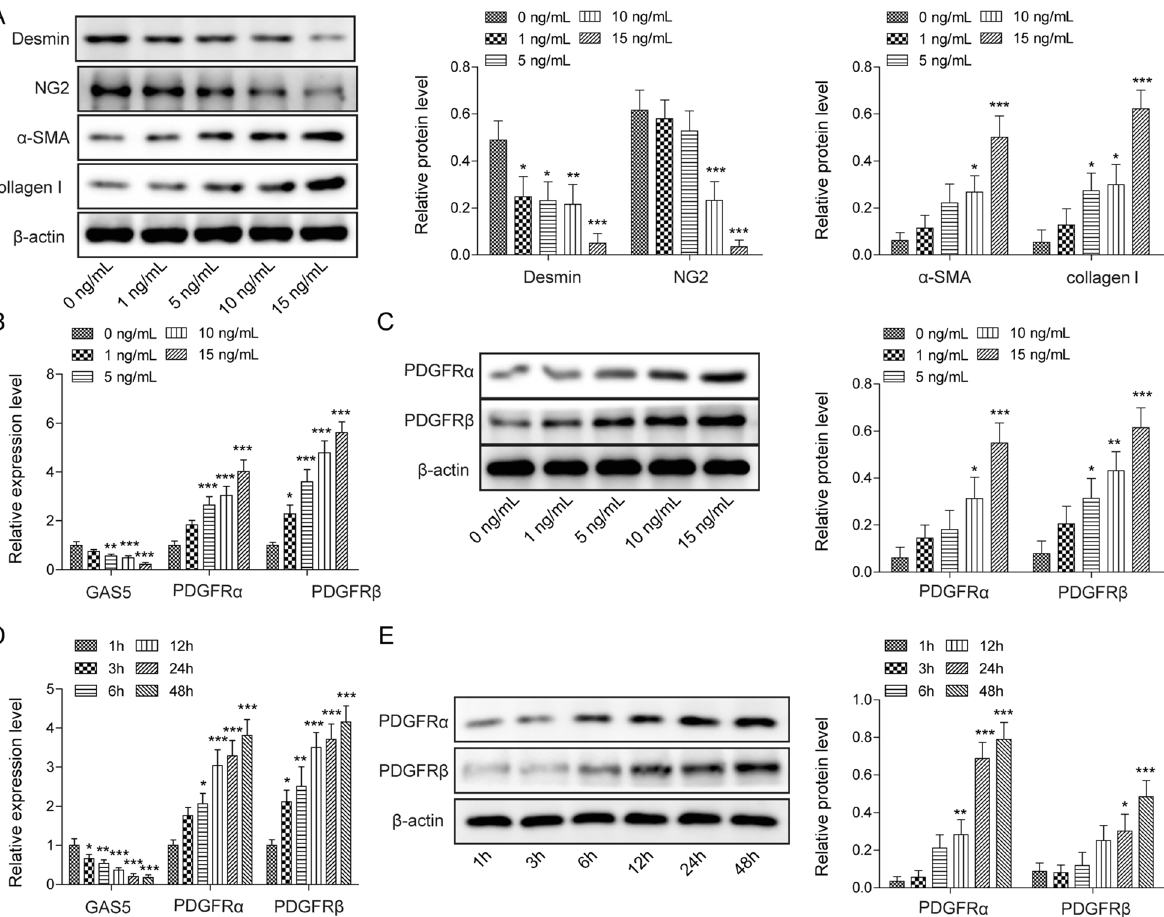
Fig. 2 TGF-β1 induced pericyte–myofibroblast transformation in a dose- or time-dependent manner. Pericytes were exposed to different TGF-β1 concentrations (0, 1, 5, 10, and 15 ng/mL) for 12 h. A Western blotting analysis of the levels of pericyte markers (desmin, NG-2) and myofibroblast markers (α-SMA, collagen I). B RT-qPCR analysis of the expressions of GAS5 and PDGFR α/β in pericytes. C The expression of PDGFR α/β was evaluated via Western blotting. Pericytes were treated with 10 ng/mL of TGF-β1 at different time periods (1, 3, 6, 12, 24, and 48 h). D The expressions of GAS5 and PDGFR α/β were examined via RT-qPCR. E Western blotting analysis of the expression of PDGFR α/β. For A–E,